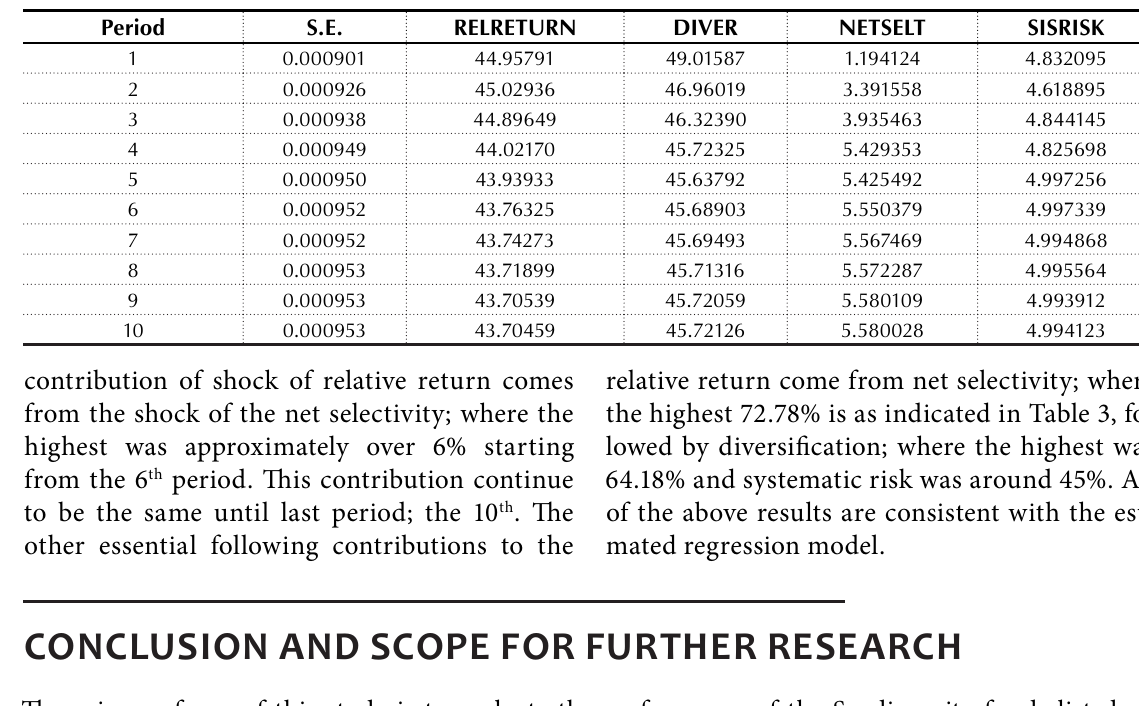
Table 6. Variance decomposition of